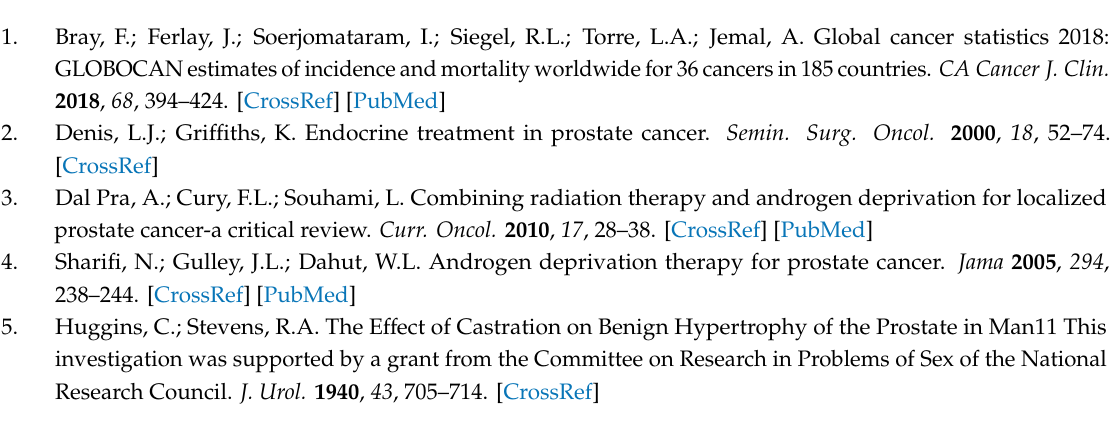
Figure S1: Multiple comparisons between the combination of the indicated antiandrogens and IR. Figure S2: Second generation ADT therapy enhances the IR e ff ect at least 2 fold. Figure S3: Quantitation of individual γ H2AX and 53BP1 foci. Figure S4: Second generation AHT does not a ff ect cell cycle distribution after IR. Figure S5: Second generation AHT does not increase apoptosis after IR. Figure S6: Abiraterone acetate e ffi ciently suppresses DSB-repair in fresh PCa tissues after ex-vivo irradiation. Figure S7: Second generation AHT does not increase apoptosis after IR. Figure S8: Bicalutamide does not inhibit DSB repair after IR. Figure S9: Abiraterone acetate e ffi ciently suppresses DSB-repair in fresh PCa tissues after ex-vivo